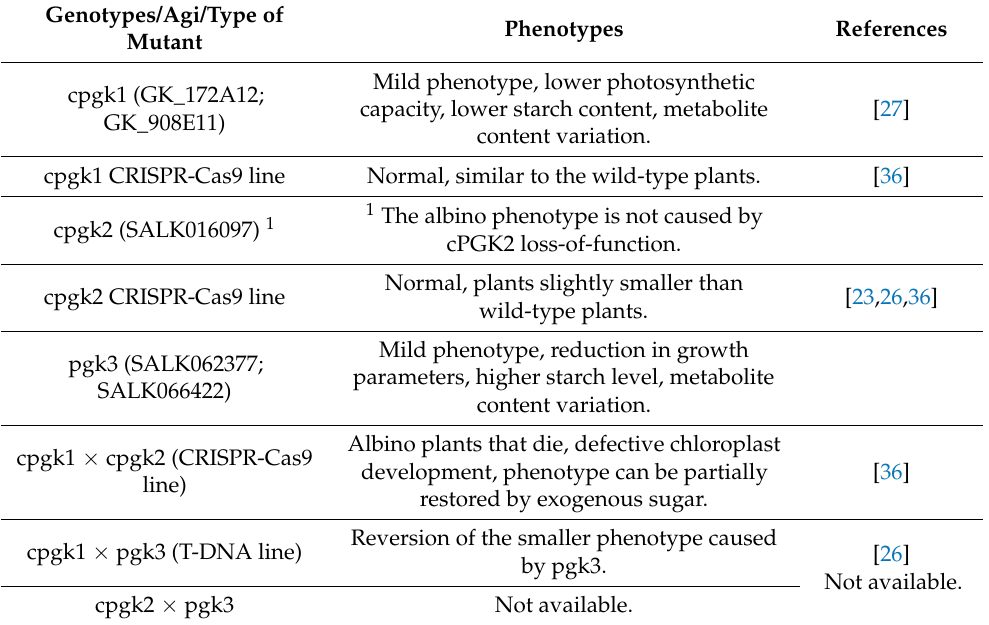
Table 1. Summary of phenotypic analyses of the current Arabidopsis PGKs mutants. The expression analysis of PGKs genes in each of these lines reveals that the cpgk1 ( GK_172A12 ; GK_908E11 ) lines are knock down, while cpgk2 and pgk3 ( SALK062377 ; SALK066422 ) lines are complete knockout